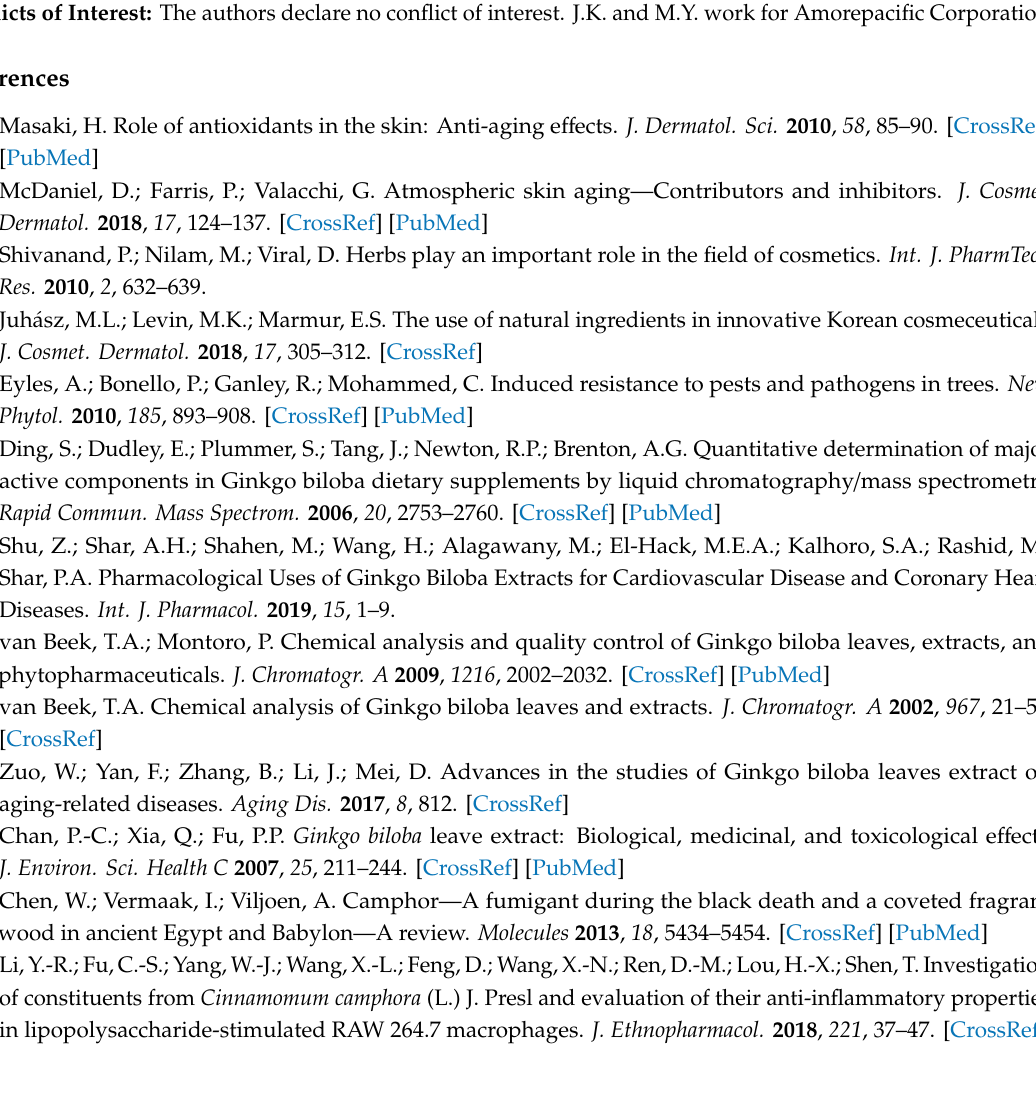
Supplementary Materials: The following are available online at http: // www.mdpi.com / 2076-3417 / 9 / 13 / 2581 / s1, Table S1. E ff ects of the molar ratios between glycerol and xylitol on the ISO yields; Table S2. E ff ects of the added water in DES 1-5 (glycerol:xylitol, 5:1); Table S3. Fit summary of the models; Table S4. ANOVA results of the established models for each response; Figure S1. Chromatographic profiles of the three extracts of (a) Ginkgo biloba , (b) Cinnamomum camphora , and (c) Cryptomeria japonica leaves prepared using 70% w / w DES 1. Peak identification: ISO,